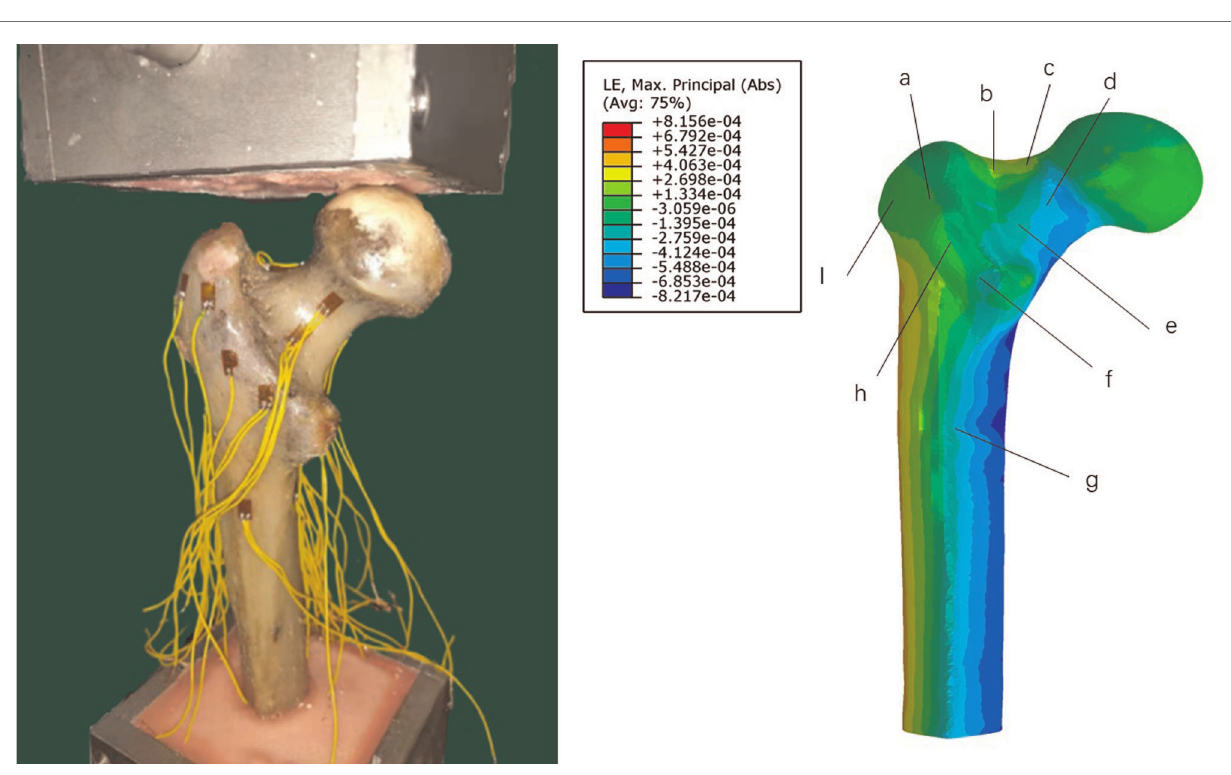
FIGURE 5 | Results of the validated experiment. ( A ): biomechanical study; and ( B ): fi nite-analysis